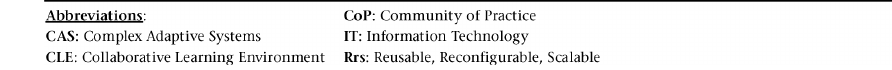
Figure 1: Agility = knowledge management + response ability (Dove, 1999, p.